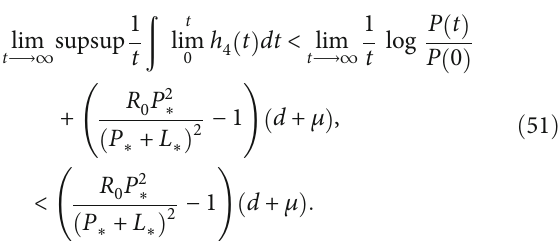
w.r.t and the parameters β 0